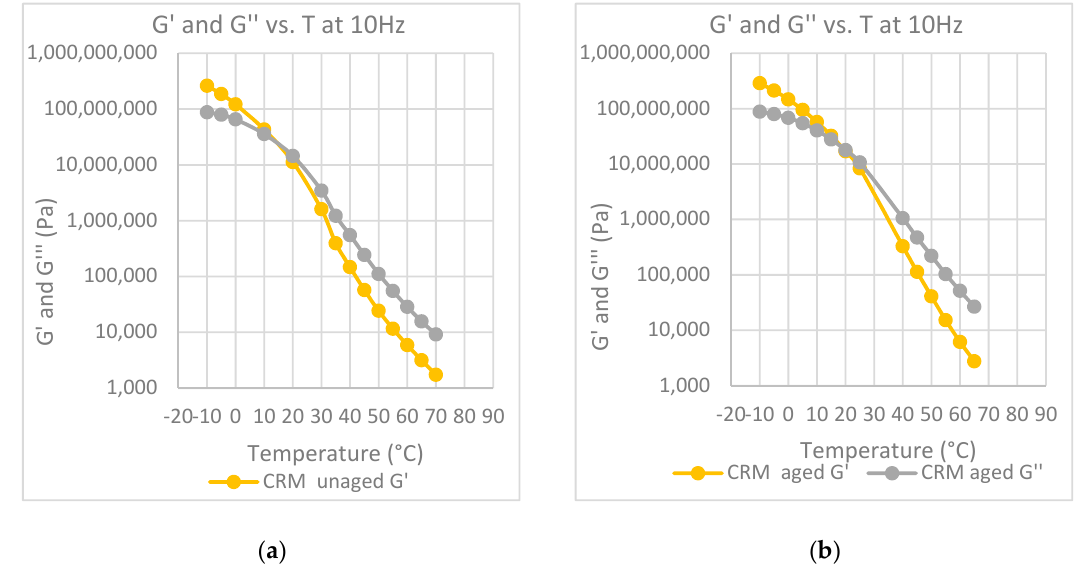
Figure 10. Elastic modulus, G ′ and loss modulus, G ′′ , at 10 Hz, as a function of temperature: ( a ) binder modified with CRM before aging; ( b ) binder modified CRM after aging at the RTFOT.